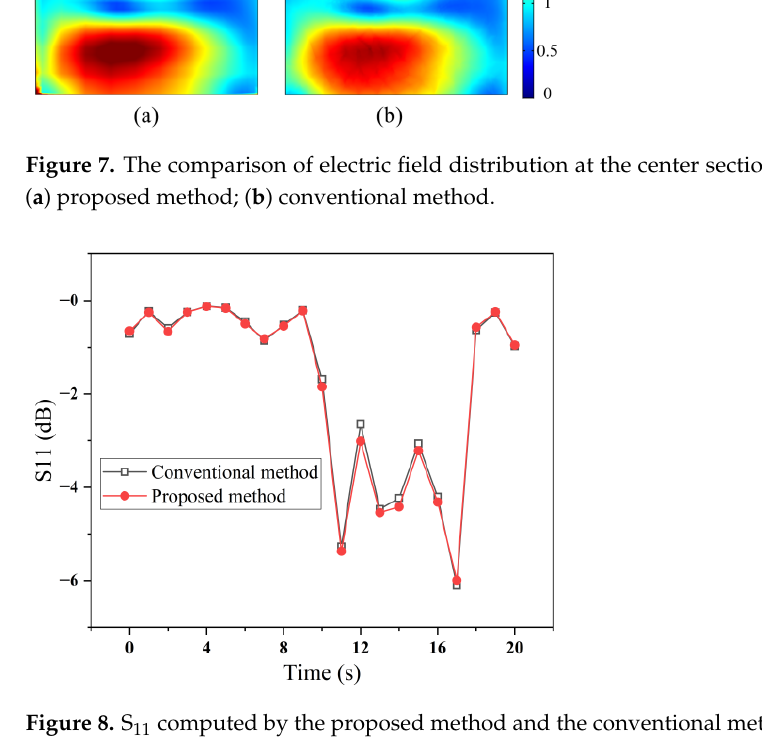
Figure 7. The comparison of electric field distribution at the center section of the potato ( t = 10 s): ( a ) proposed method; ( b ) conventional method.